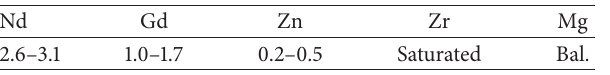
Table 2: Chemical composition (in wt.%) of EL21 Mg-alloy. Nd Gd Zn Zr Mg